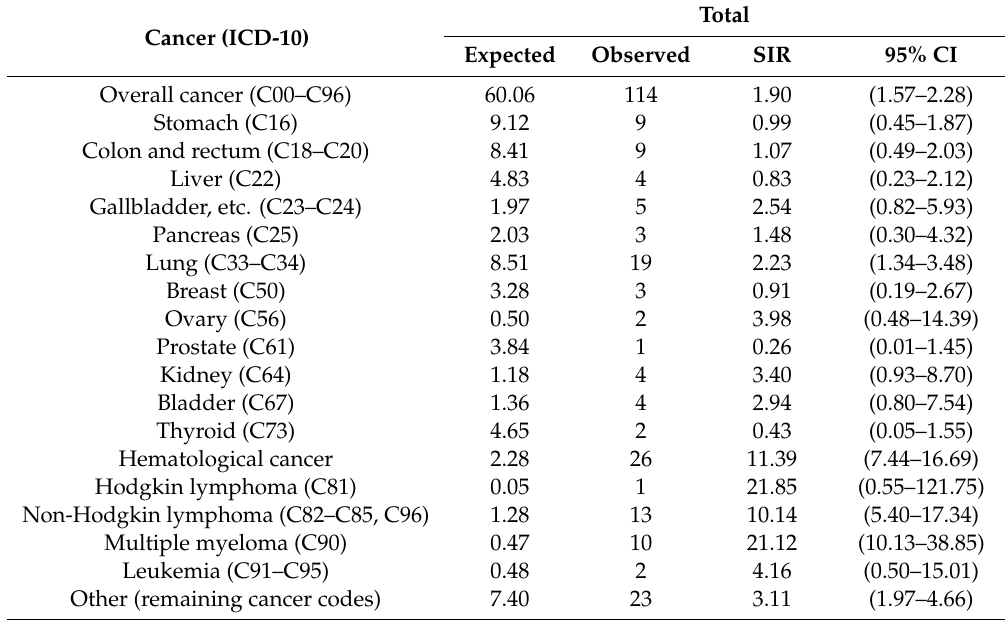
Table 2. Estimation of cancer risk in AAV